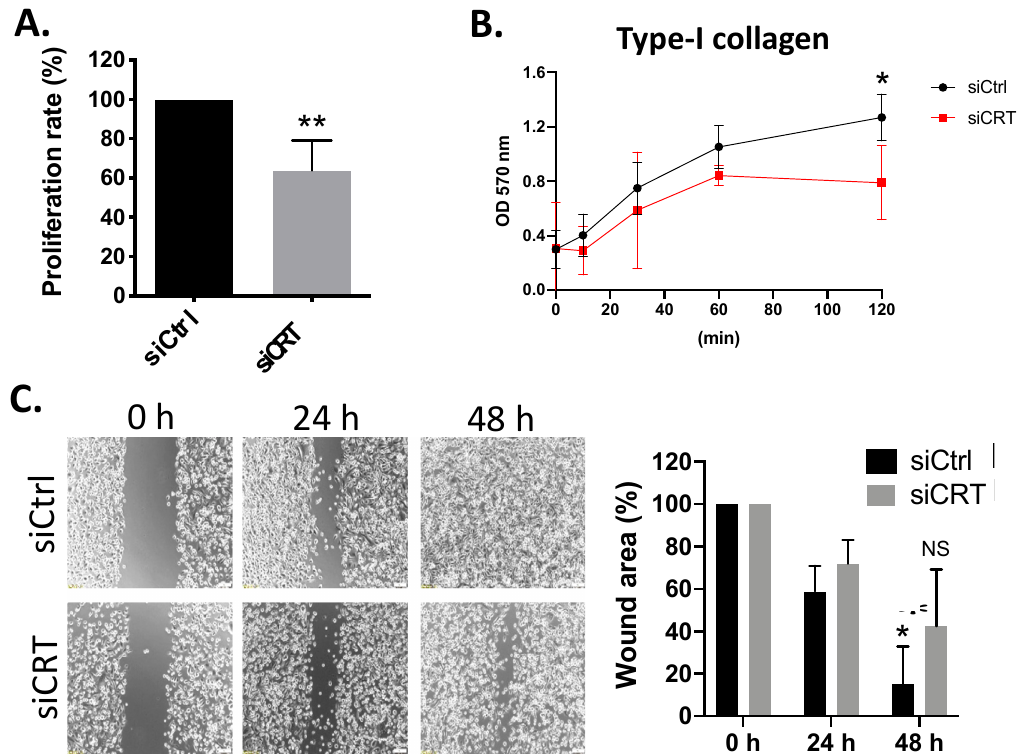
Figure 6. CRT regulates cell proliferation, adhesion and cell migration in PC-3 cells. ( A ) Total cell numbers of siCRT- and siCtrl-transfected PC-3 cells were counted and analyzed. ( B ) Type I collagen- mediated cell adhesions were shown. siCRT- and siCtrl-transfected PC-3 cells were plated on Type-I collagen-coated plate for 0, 10, 30, 60, and 120 min. ( C ) Representative images from wound-healing assays performed with cells transfected with siCRT or siCtrl. Confluent cell monolayers were imaged at 0, 24, and 48 h after wound scratching. Scale bar = 100 μ m. Quantification of wound area was conducted by comparing the area of the wound at 24 or 48 h to that at 0 h. Each experiment was performed in triplicate, and wound healing was calculated in 4 fields/experiments. * p < 0.05, ** p < 0.01.